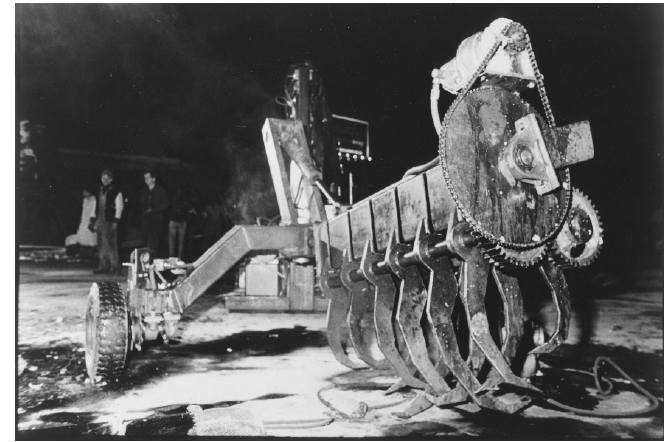
Figure 14. Scene from Misfortunes of Desire: Acted Out at an Imaginary Location Symbolizing Everything Worth Having , a mechanical performance by SRL, 17 May 1988, parking lot of Shea Stadium, Queens, New York. © Survival Research Labs.